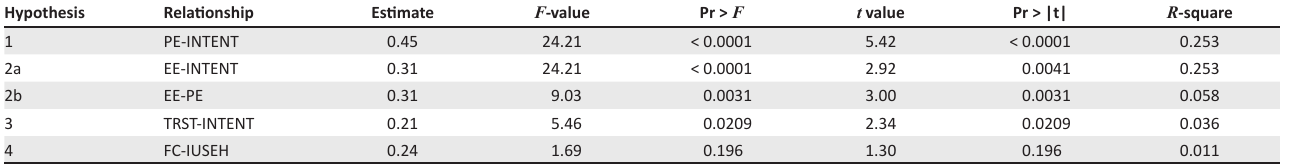
TABLE 3: Regression analysis